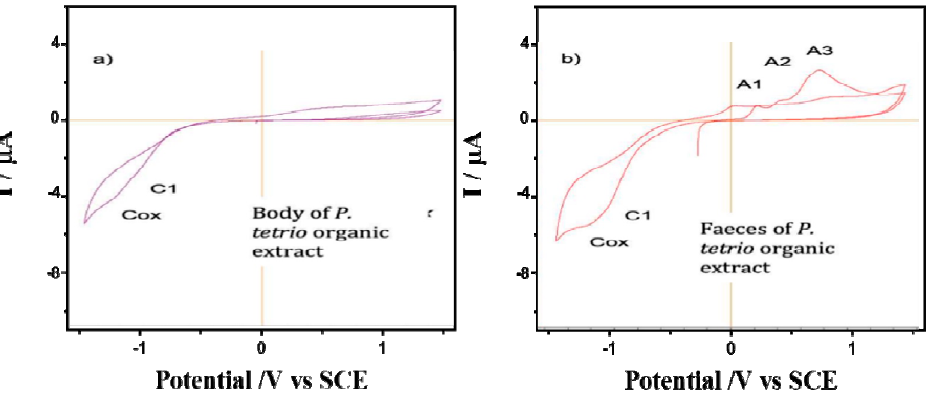
Figure 4. Cyclic voltammograms of films from ( a ) P. tetrio ’s bodies and ( b ) P. tetrio ’s excrement after predation on leaves of A. cathartica on glassy carbon electrode in contact with air-saturated 0.10 M phosphate buffer at pH 7.0. Potential scan rate 10 mV.s − 1 . A comparison was made between the CV of films from the water extracts of healthy and spoiled leaves of A. cathartica in contact with air-saturated 0.10 mol L − 1 phosphate buffer at pH 7.0 (Figure 5). Here, signal A 1 appears clearly recorded in the healthy leaves and is accompanied by a well-defined cathodic peak at—1.25 V (C 2 ). Signal C 2 disappears in the CV of the damaged leaves, while signal A 1 decreases and signal A 3 is clearly visible at 0.78 V. This result confirms hypothesis 3, which shows a reaction of leaves against her- bivory; the disappearance of signal C 2 and the appearance of signal A 3 are a result of her- bivory. This CV is reproduced to some extent reproduced in the aqueous extracts of P. tetrio and its excrement, as shown in Figure 6, thus suggesting the existence of common electroactive compounds. Figure 5. Cyclic voltammograms of films from the water extracts of ( a ) healthy and ( b ) predated leaves of A. cathartica on glassy carbon electrode in contact with air-saturated 0.10 M phosphate buffer at pH 7.0. Potential scan rate 10 mV.s -1 .